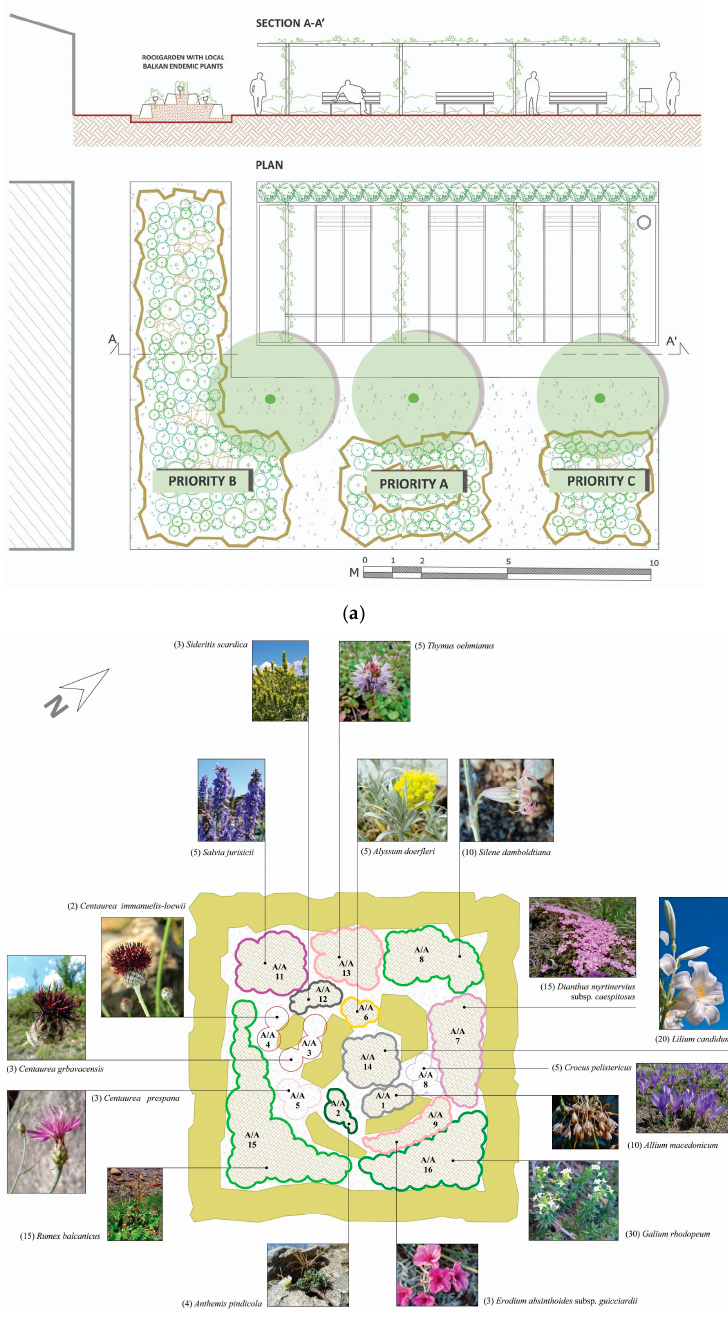
Figure 8. ( a ) Plan of the new thematic section targeting priority species of the cross-border area of Greece and the Republic of Northern Macedonia presented in three rock gardens in front of a sitting area under a metal pergola in the Balkan Botanic Garden of Kroussia, Northern Greece. ( b ) Planting plan of the Priority A rock garden (approximate size 3 m × 3 m) displaying 16 threatened and near threatened plants with numbers in parentheses indicating the plant individuals established in each section of the plant display (e.g., five individuals of Thymus oehmianus ).